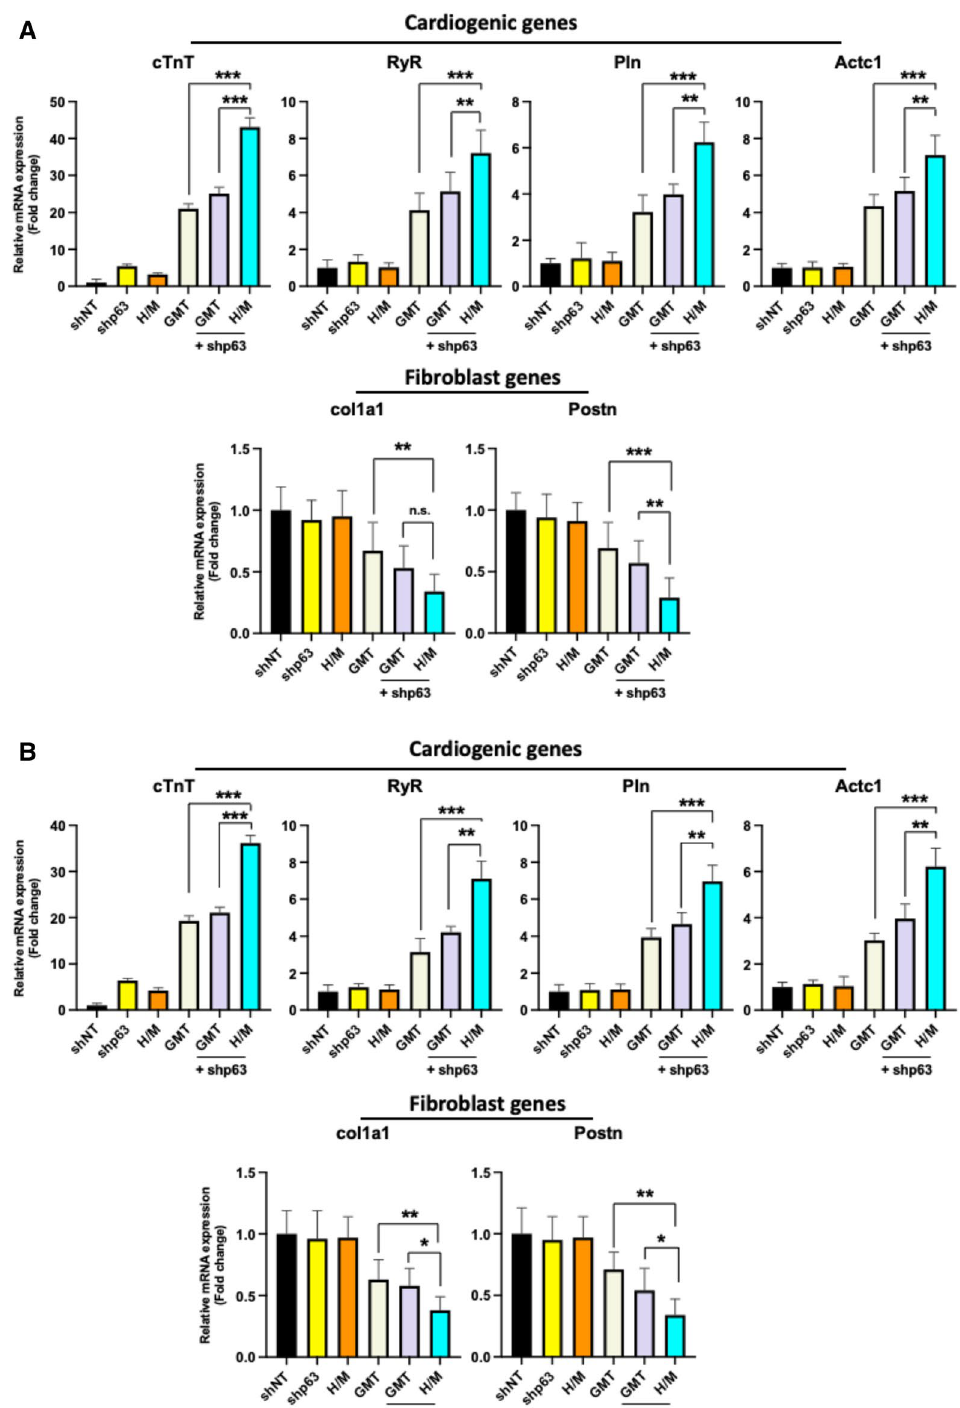
Figure 1. p63 silencing in combination with Hand2/Myocardin enhances cellular reprogramming in rat cardiac fibroblasts. Cardiomyocyte and fibroblast marker gene expression in neonatal ( A ) and adult ( B ) rat cardiac fibroblasts (CFs), as assessed by qRT-PCR two weeks after treatment with shp63 with or without Hand2/Myocardin (H/M) versus treatment with Gata4, Mef2c, and Tbx5 (GMT) with or without shp63 (n = 3, ***p < 0.001, **p < 0.01, *p < 0.05, n.s. not significant), shNT short hairpin